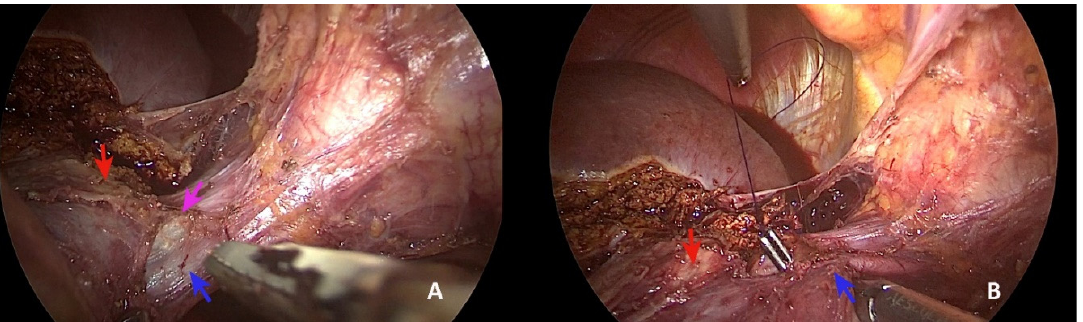
Figure 3. Superior dissection of common hepatic trunk. ( A , B ) Exposure of the right margin of the left hepatic vein (blue arrow: left hepatic vein; violet arrow: middle hepatic vein; red arrow: liver metastasis).